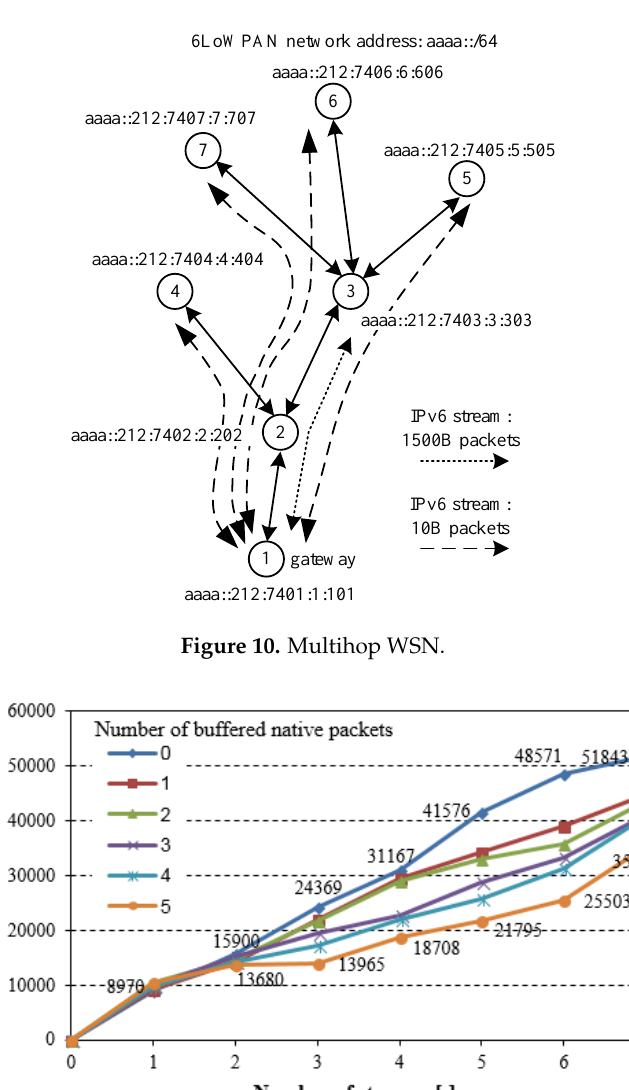
Figure 9. Packet loss ratio (simple testing scenario). Sensors 2018 , 18 , x FOR PEER REVIEW